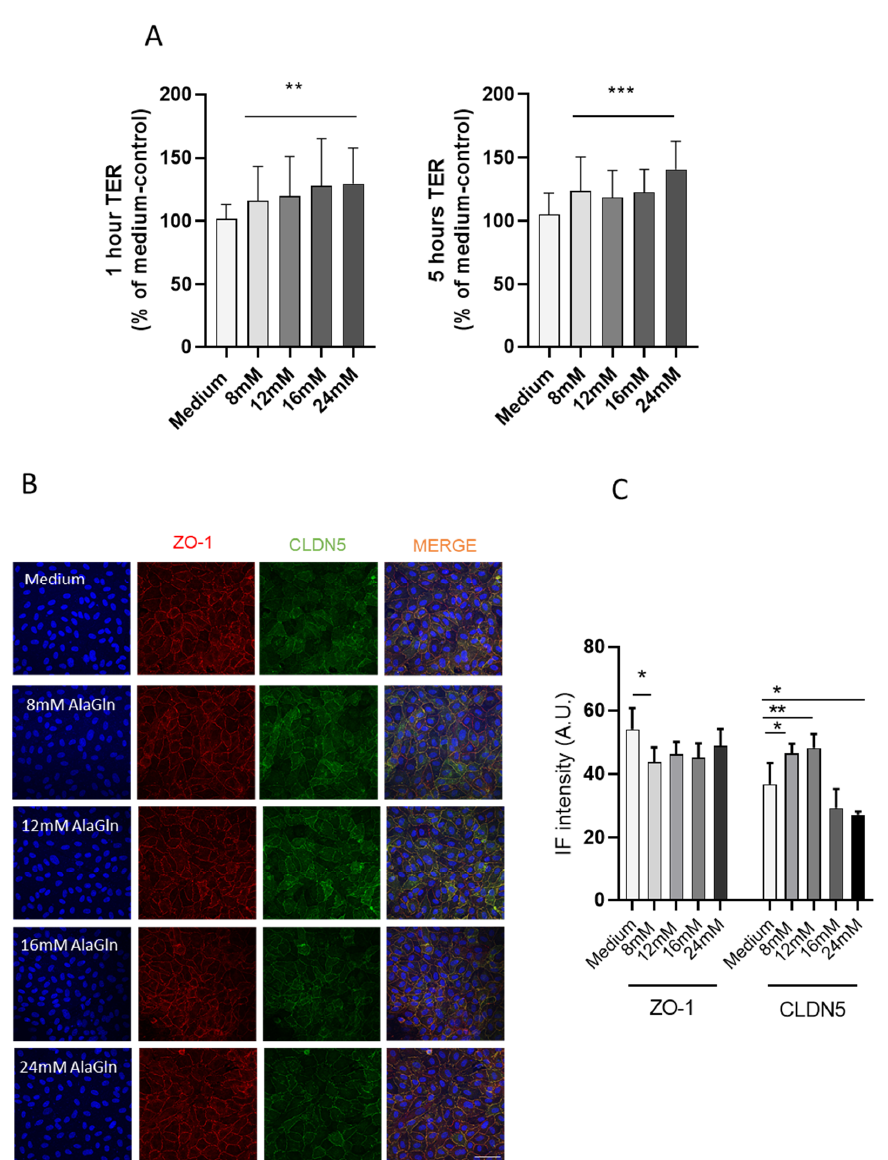
Figure 1. ( A ) Alanyl-glutamine (AlaGln) dose-dependently increased transendothelial resistance (TER) in human umbilical vein endothelial cells (HUVEC) incubated with cell medium (ANOVA p < 0.001). ( B ) gives representative zonula occludens-1 (ZO-1) and claudin-5 (CLDN5) stainings of HUVEC treated with increasing doses of AlaGln Scale bar = 50µm, ( C ) the mean and SD values of the fluorescence signal quantification of both endothelial junction proteins. Endothelial ZO-1 abundance is decreased and CLDN5 increased with 8mM AlaGln. A.U.= arbitrary units. * p < 0.05, ** p < 0.01, *** p < 0.001. 10 kDa and 70 kDa dextran transport across the endothelial barrier was dose dependently reduced with AlaGln. After four hours, 8 mM AlaGln added to medium decreased 70 kDa transport across the endothelial barrier ( p = 0.03), 10 kDa transport was unchanged ( p = 0.15; Table 1). The 24 mM AlaGln reduced 10 kDa and 70 kDa dextran transport to (32 ± 0.7) % and (61 ± 38) % of medium ( p = 0.001/0.008). Based on these findings and since effects on cellular stress response in vitro [23,49] and on peritoneal transport in PD patients [27] were studied with 8 mM AlaGln, as higher doses of AlaGln in the clinical setting may be associated with no benefit [50], this concentration was used throughout subsequent